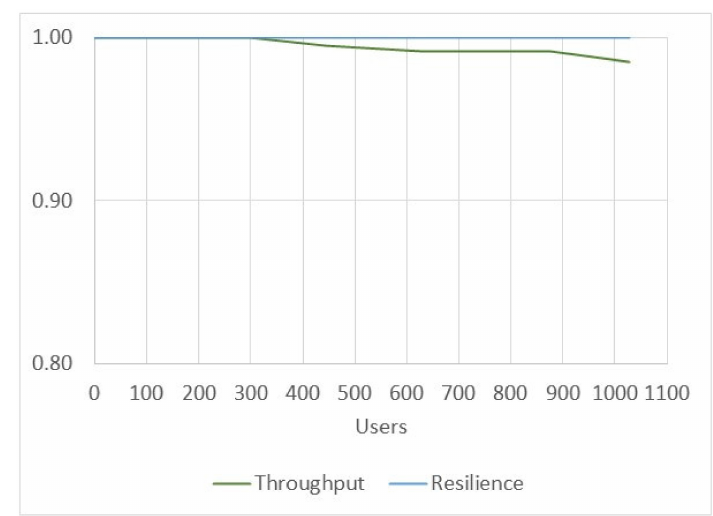
Figure 16. Throughput and resilience of the HealthyBlock prototype.